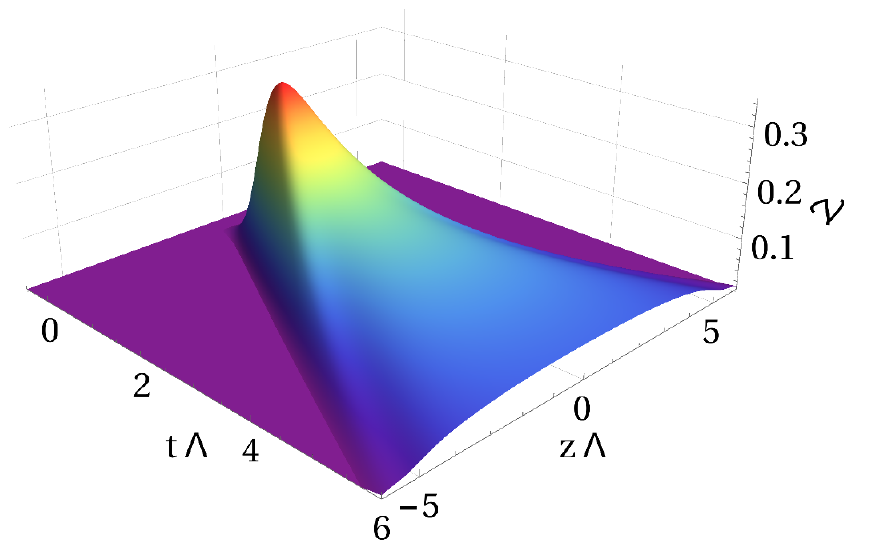
Figure 9 . Spacetime evolution of the scalar condensate, in units of (cid:3) 3 , in a collision in the (cid:30) model with (cid:22)! = 0 : 30 and (cid:22)= (cid:3) = 0 :